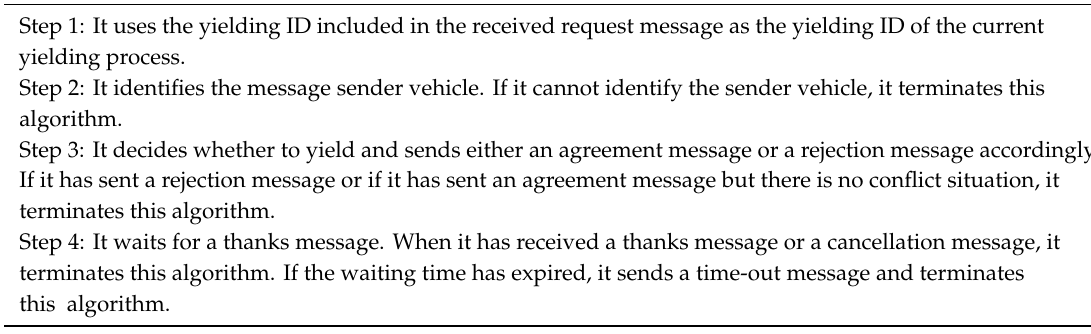
Algorithm 3. Yielding Response Algorithm